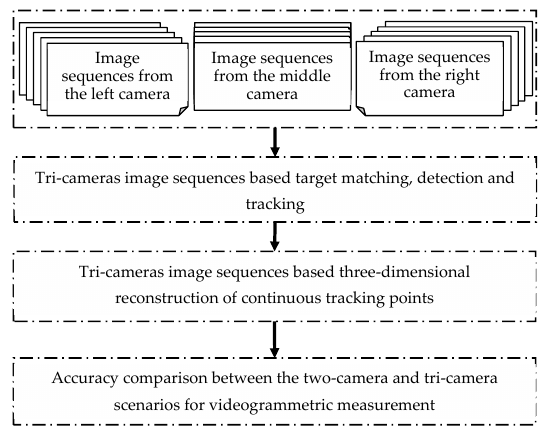
Figure 3. The framework of the tri-camera videogrammetric approach for measuring three-dimensional displacement of laminated rubber bearings on the shaking table.